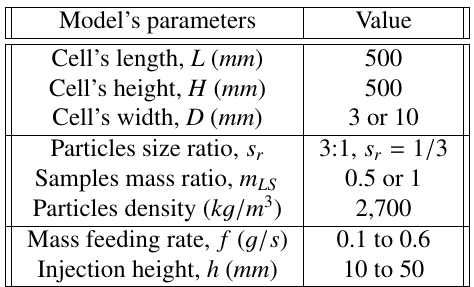
Table 1. Simulations core